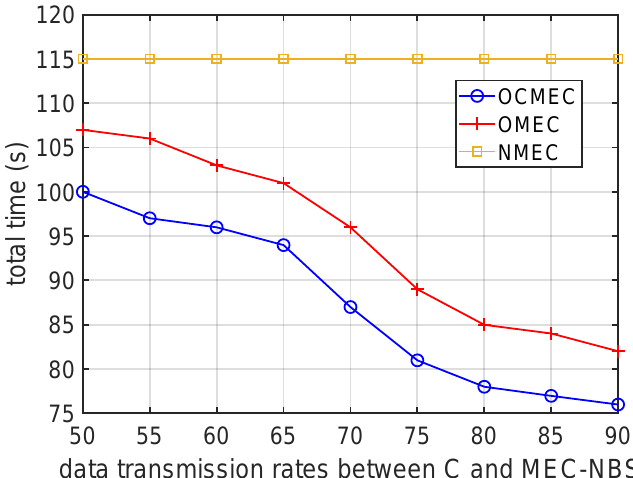
Figure 8. f gained by the 3 schemes with the increase of s C2NBS C and MEC-NBS, k = 1,2, . . . , K